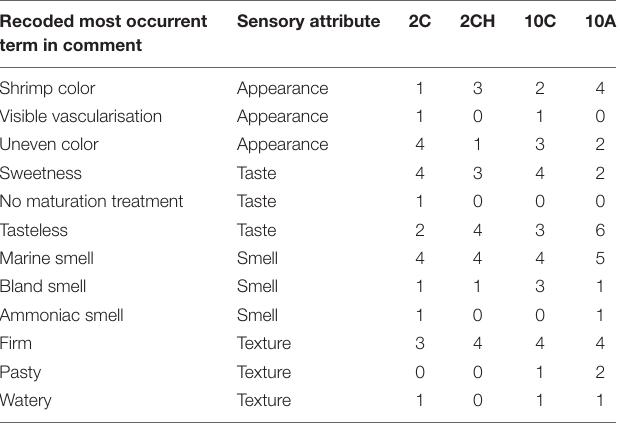
TABLE 2 | Table of occurrences of recoded most frequently used words in panelists comments.